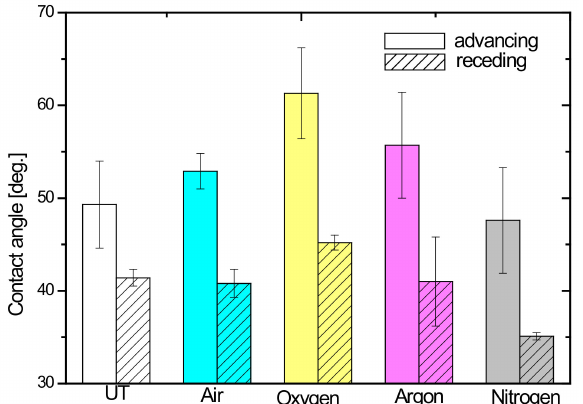
Figure 3. Advancing and receding contact angles diiodomethane measured on unmodified and modified